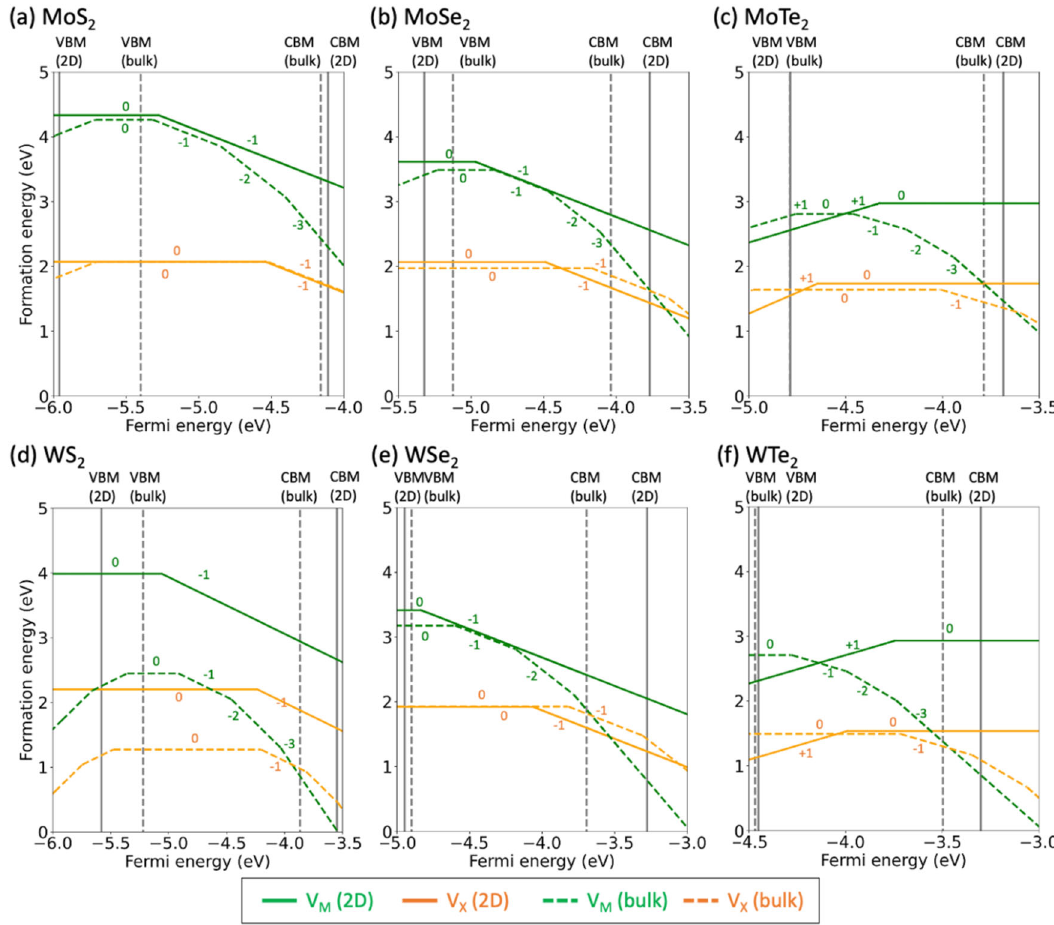
Fig. 4 Defect formation energies of metal and chalcogen vacancies in 2D (solid) and bulk (dashed) TMDs. The energies for ( a ) MoS 2 , ( b ) MoSe Table 4. Identi fi ed charge transition levels of defects from Fig.